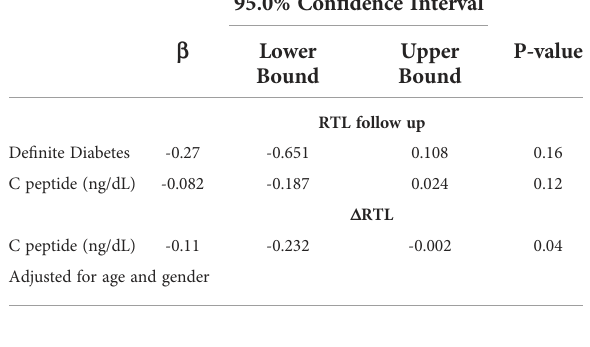
TABLE 3 Multivariate linear regression showing association of diabetes related variables at baseline in 2014 with RTL at follow up in 2019 and change in RTL ( D RTL) after adjustment for age and gender.